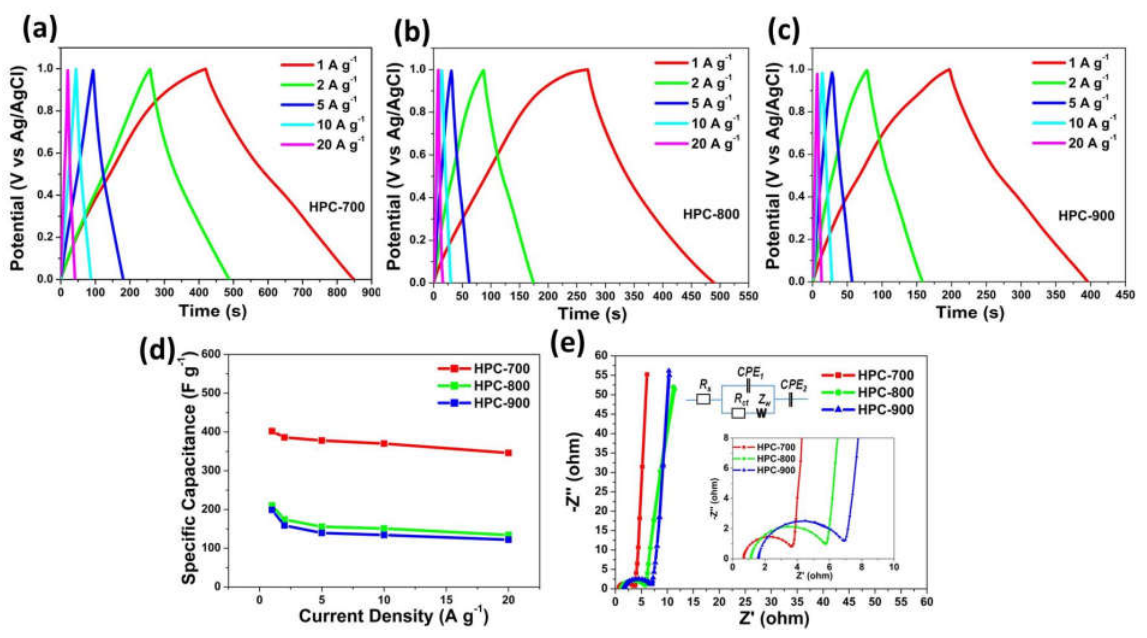
Figure 7. GCD curves of HPC-700 ( a ), HPC-800 ( b ), and HPC-900 ( c ) at different current densities; ( d ) the rate performance and ( e ) Nyquist plots of HPC-700, HPC-800, and HPC-900. The HPC-700//HPC-700 symmetric supercapacitor was further assembled. The GCD